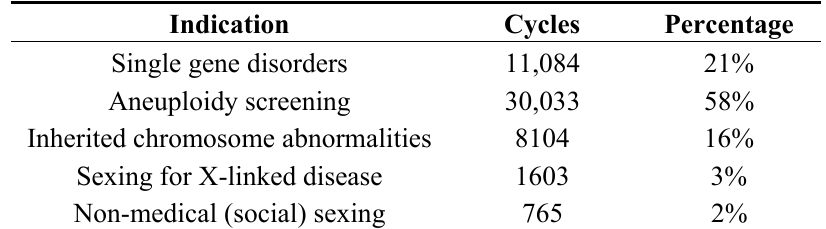
Table 1. Data from the ESHRE Preimplantation Genetic Diagnosis (PGD) Consortium, including their 14th data collection (Traeger-Synodinos et al. 2013 [10]) and the recorded indications for PGD in 51,589